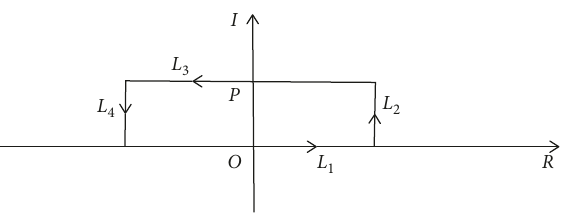
Figure 3: Choice of the